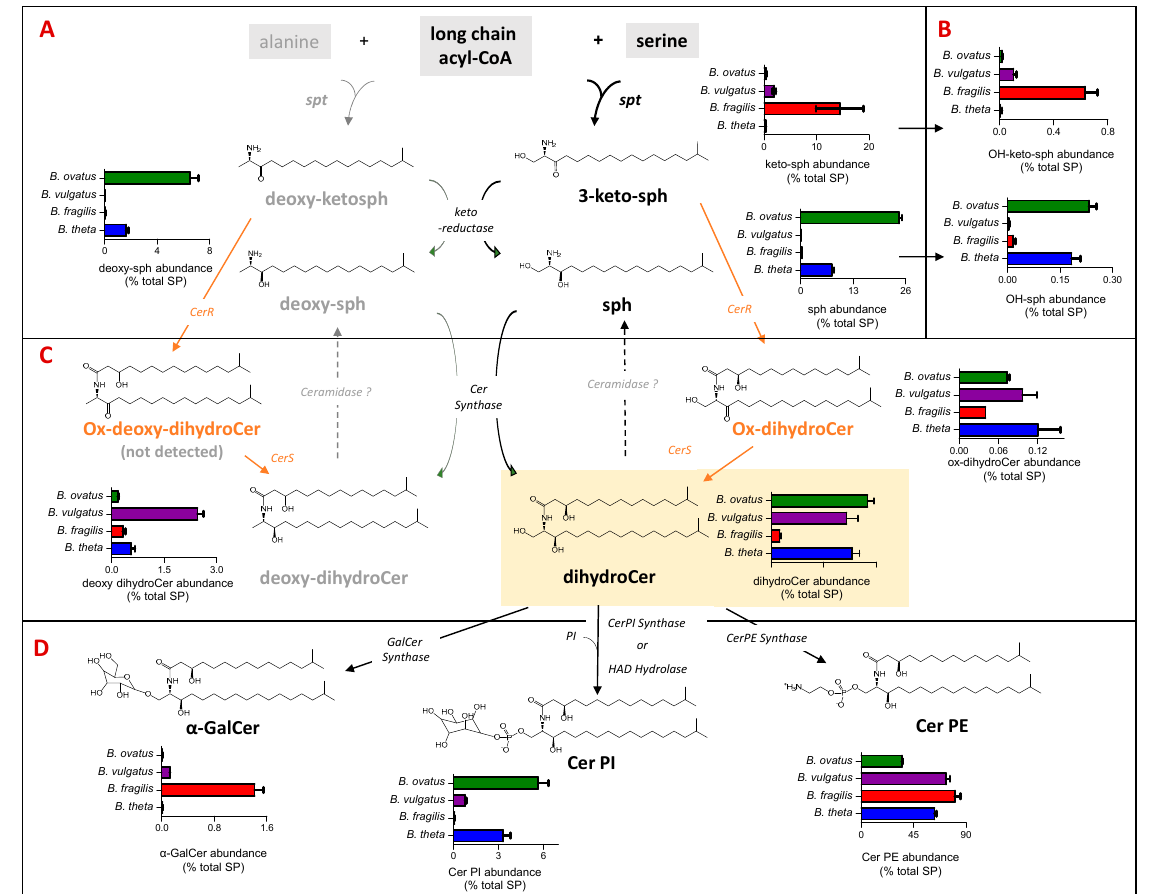
Figure 3. Dihydroceramide phosphoethanolamine (Cer PE) is the most abundant sphingolipid (SP) detected in all four Bacteroides species . The schematic indicates the relative representation of each lipid species and the proposed genetic and biochemical pathways contributing towards their production. ( A ) Relative abundance (expressed as % total PS) of sphingoid bases, which include keto-sphinganines (keto-sph) and sphinganines (sph) derived from either serine or alanine (deoxy derivatives) among the four Bacteroides species. ( B ) Relative abundance (expressed as % total SP) of hydroxy keto-sph and sph; exact position of hydroxylation is unknown. ( C ) Relative abundance (expressed as % total SP) of ceramide (Cer) lipids among the four Bacteroides species derived from either serine (dihydroCer) or alanine (deoxy-dihydroCer). ( D ) Relative abundance of complex Bacteroides SP (expressed as % total SP), including α -galactosyl dihydroCer ( α -GalCer) and the phos- phosphingolipids dihydroCer phosphosethanolamines (Cer PE) and dihydroCer phosphoinositols (Cer PI).